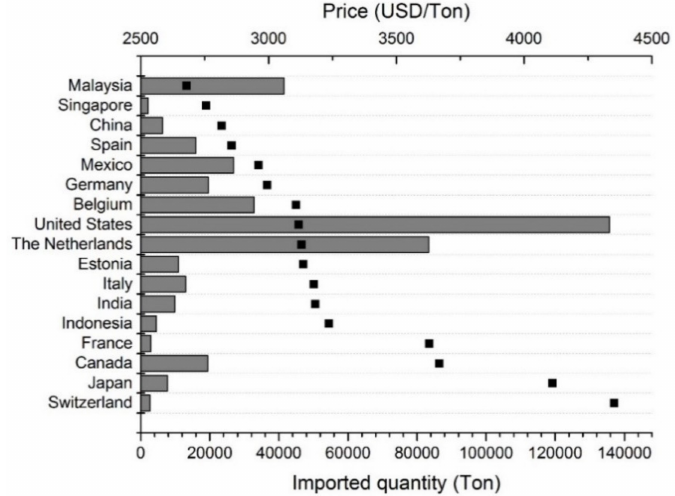
Figure 7. Identification of potential markets for Colombian specialty cocoa: The gray bars show the quantity of imported fine flavor cocoa beans plus the equivalents in fine flavor cocoa beans for cocoa-derived products (in tons). Countries that recorded in 2015 at least 1000 imported tons were considered. The points represent the price (USD / ton) o ff ered by each country (elaborated using data from Reference [37], accessed on 2 August